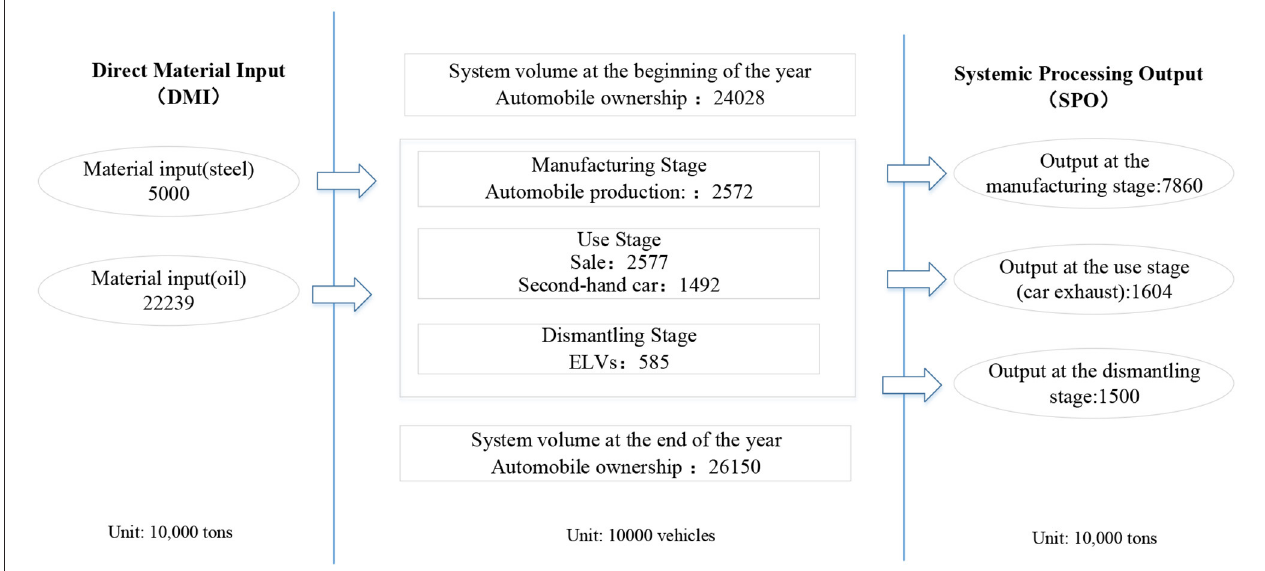
FIGURE 2 | Schematic diagram of material flow system of China’s automobile industry (2019).